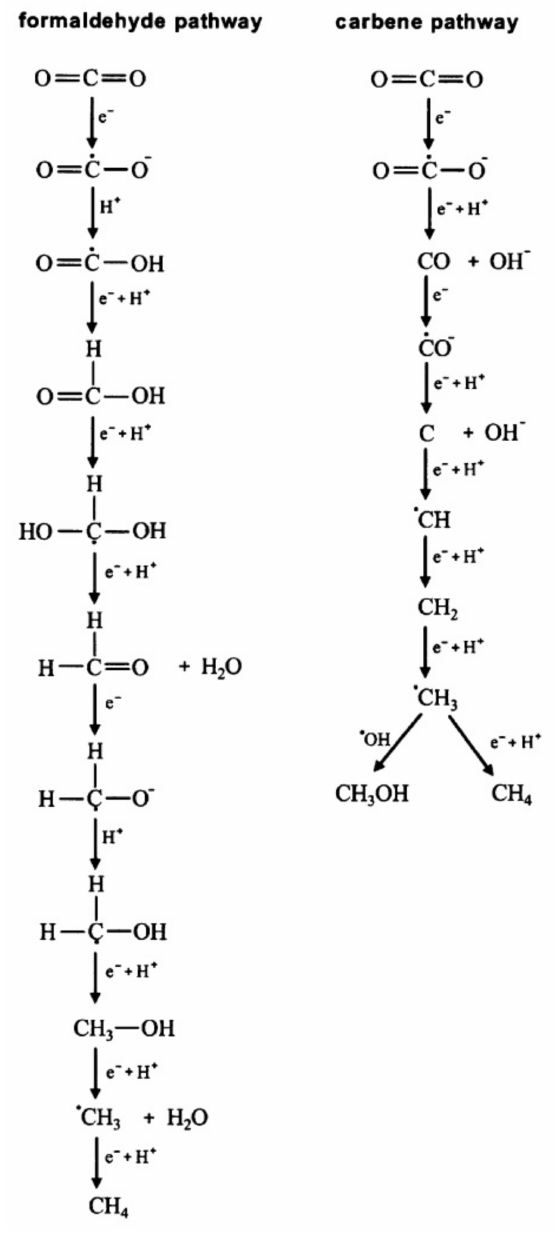
Figure 22. Two proposed pathways for the CO 2 photoreduction into CH 4 : formaldehyde (left) and carbene (right)